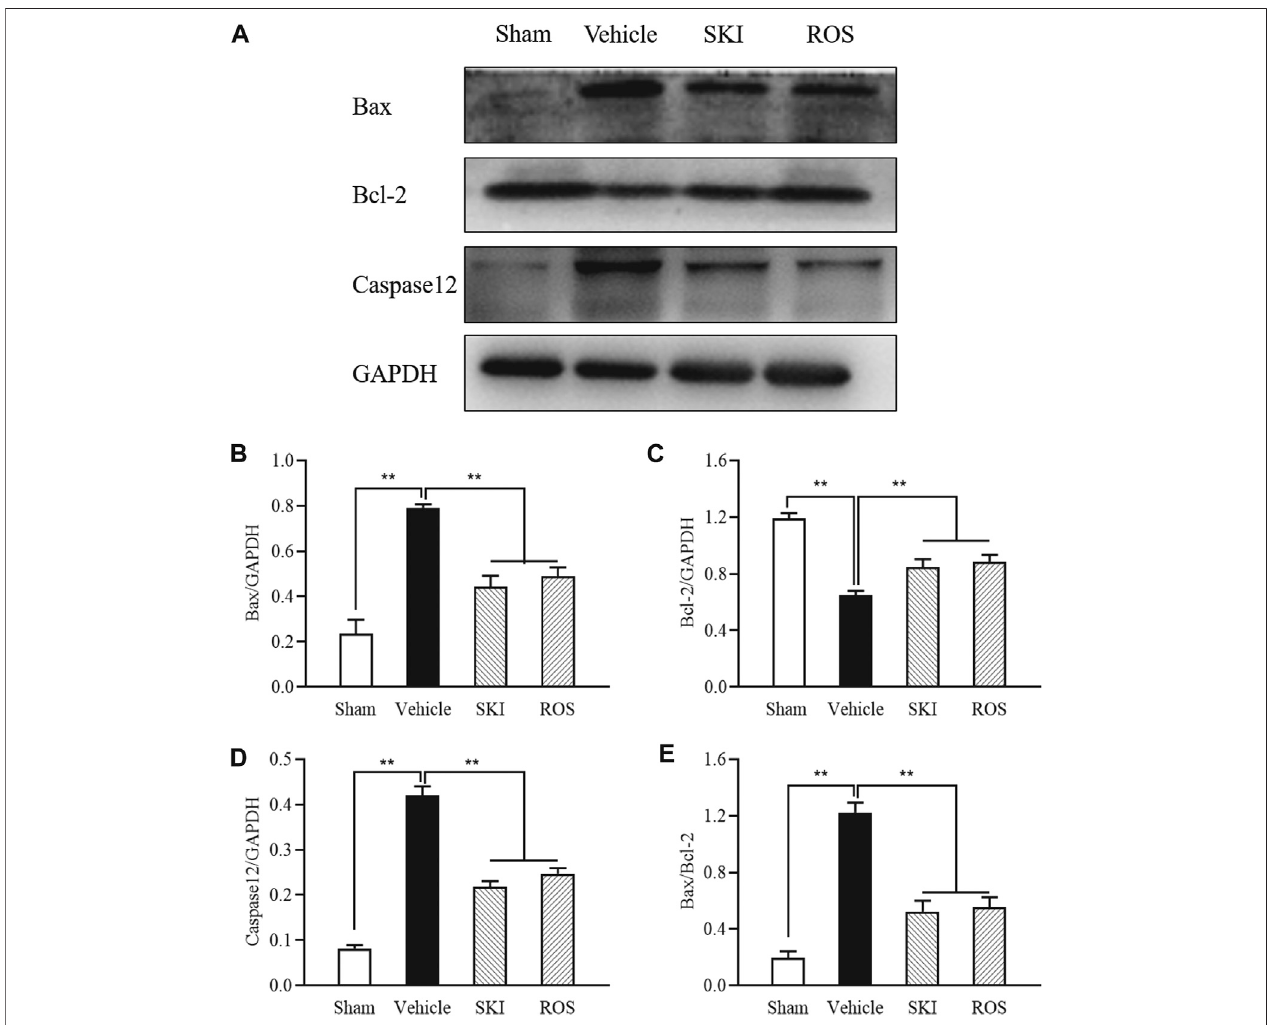
FIGURE9| TheeffectsofSKIandROSontheproteinexpressionlevelsofBax,Bcl-2,andcaspase12, invivo . (A) WBanalysisofBax,Bcl-2,andcaspase12,inthe kidney; (B – E) TherateofBax,Bcl-2and caspase12 toGAPDH,respectively, and therateofBaxtoBcl-2. Dataareexpressed asmean ± S.E.** p < 0.01. Abbreviations: WB, Western blot; GAPDH, glyceraldehyde-3-phosphate dehydrogenase; ROS, rosiglitazone; SKI, Shenkang injection.